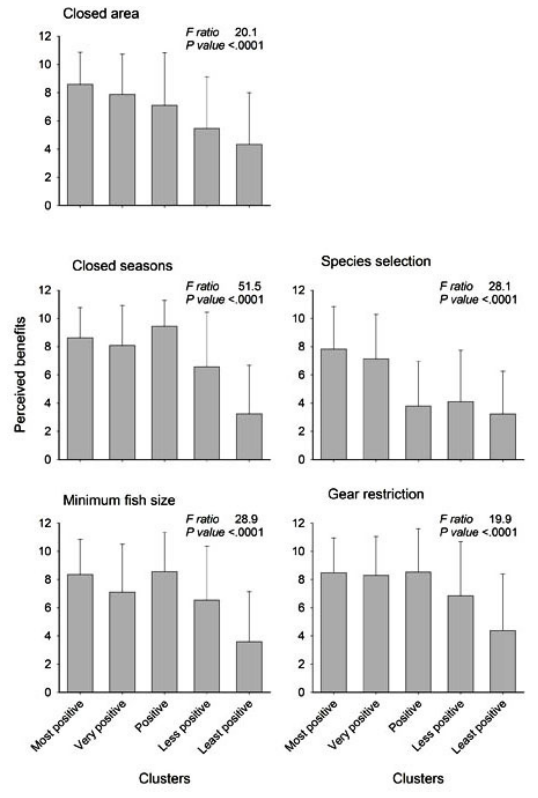
Fig. 4. Mean (SD) perceived personal benefit for each management restriction presented for the five village clusters (Fig. 2). A score of 10 indicates the maximum benefit. Results of ANOVA for differences between village clusters are